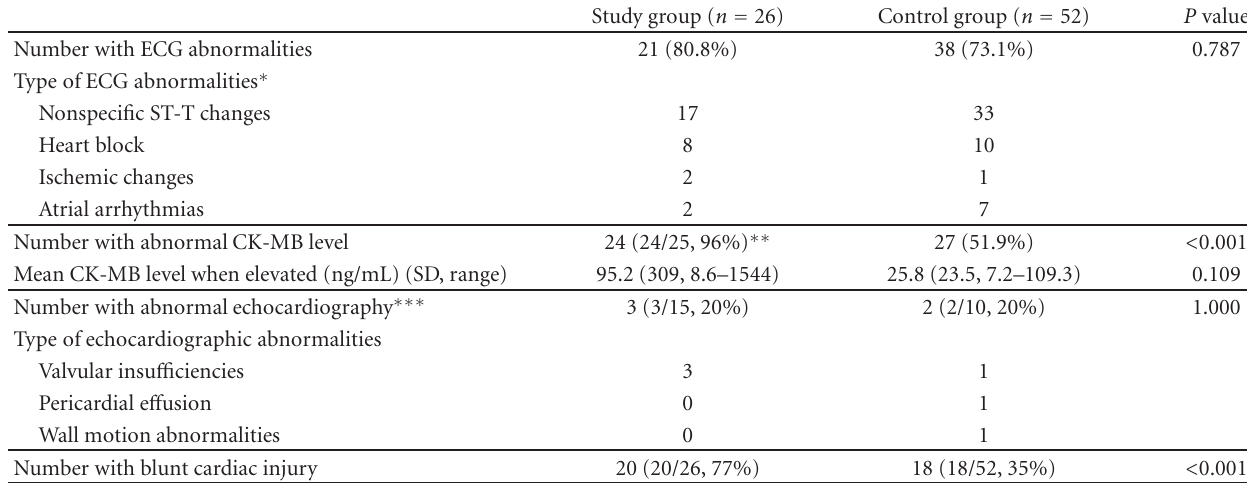
Table 3: Details of cardiac test results including ECG, CK-MB assay, and